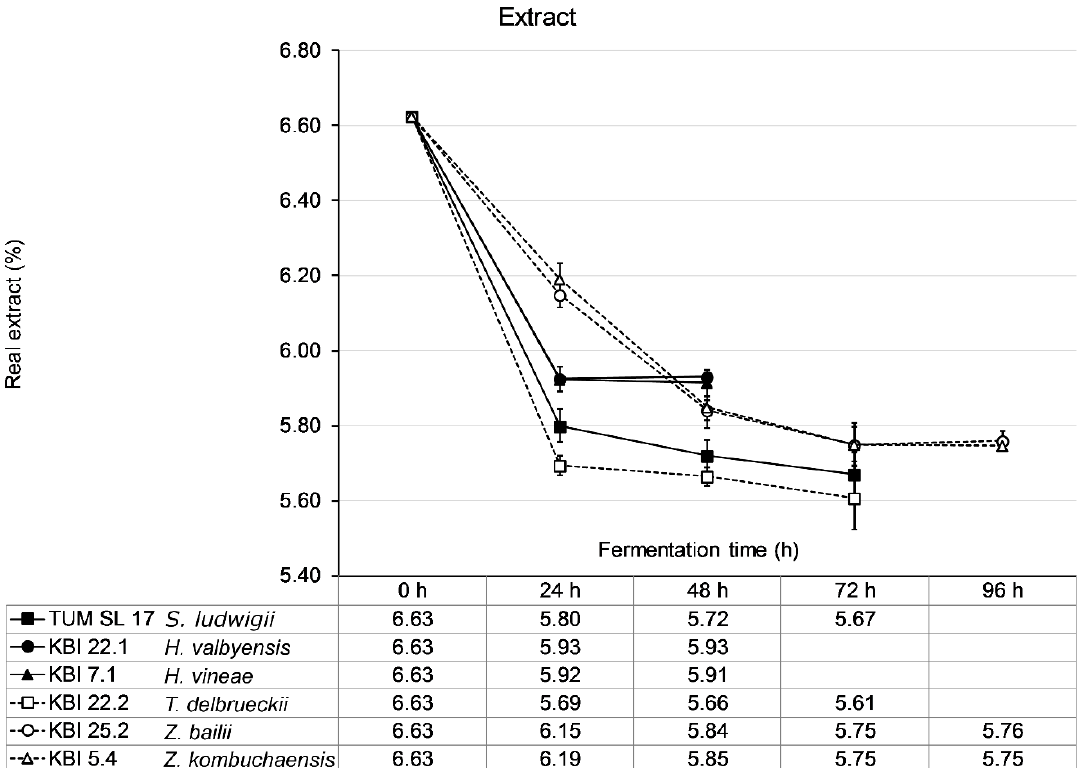
Figure 3. Drop in real extract for the investigated maltose-negative yeast strains.